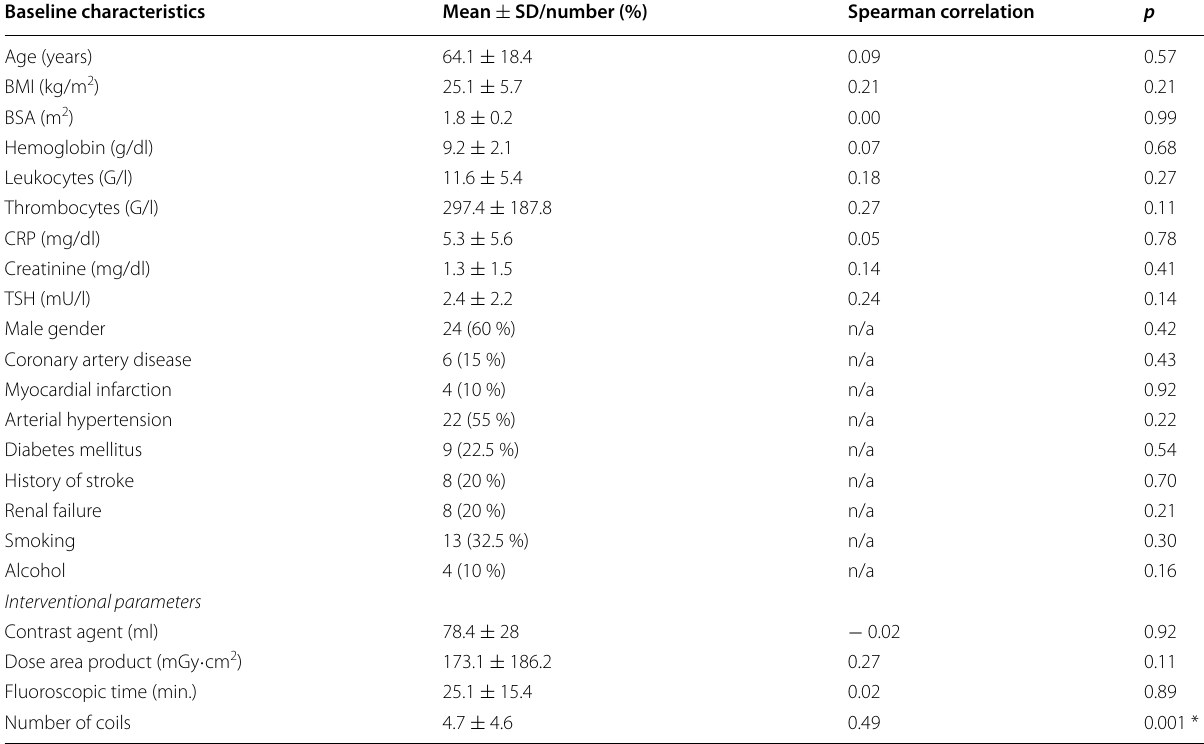
Table 2 Demographic and clinical overview and the comparison to the simulation success